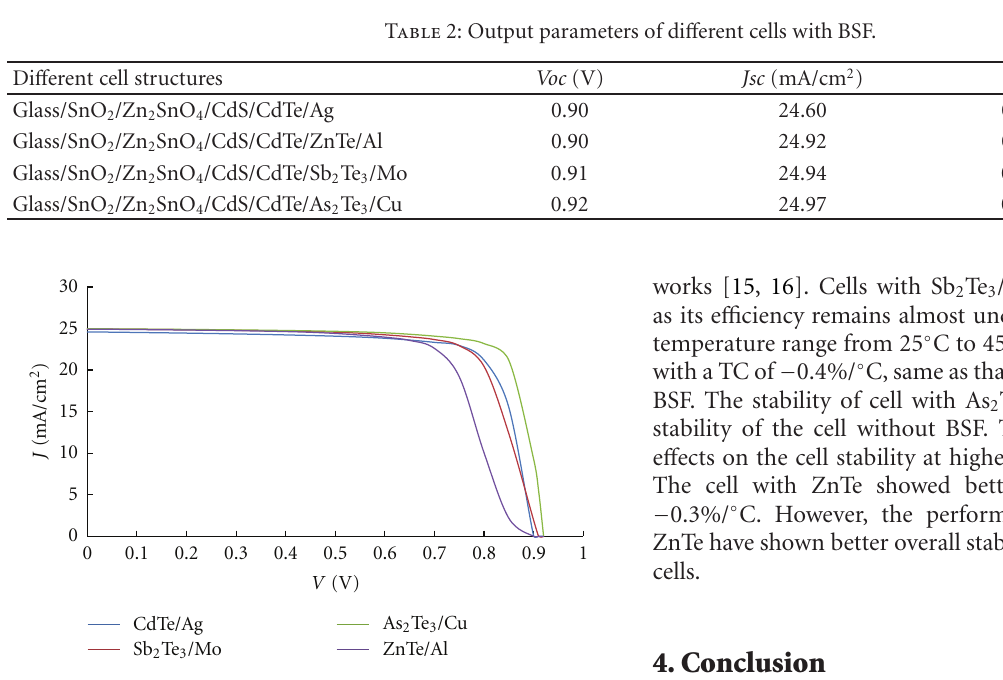
Figure 8: J - V characteristics of the proposed cells.